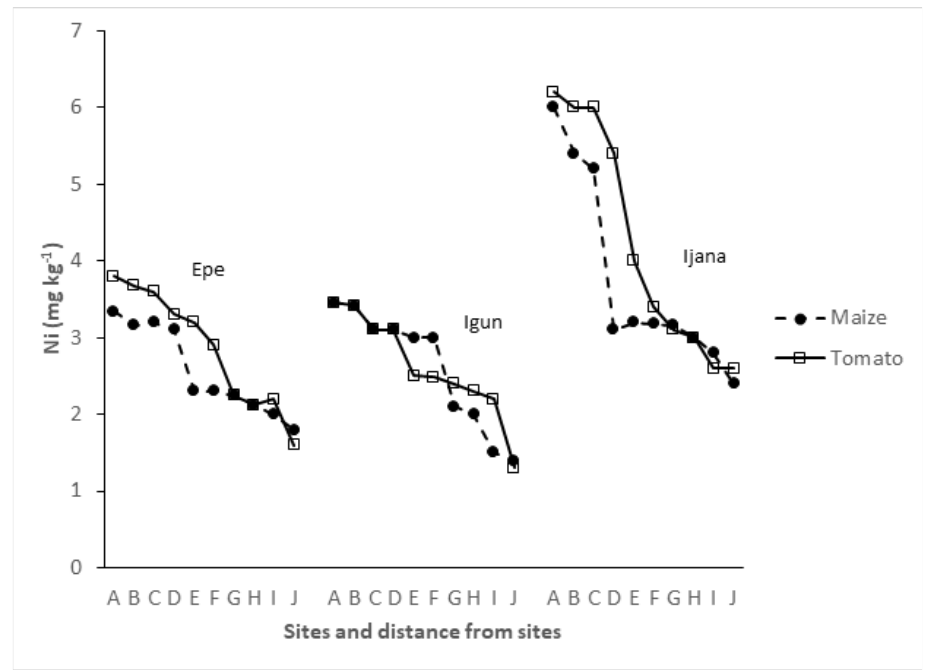
Figure 10: Concentrations of Ni in maize and tomato crops at Epe, Igun & Ijana (0 – 900 m) sites. A = 0 m from site; B = 100 m from site; C = 200 m from site; D = 300 m from site; E = 400 m from site; F = 500 m from site; G = 600 m from site; H = 700 m from site; I = 800 m from site; J = 900 m from site